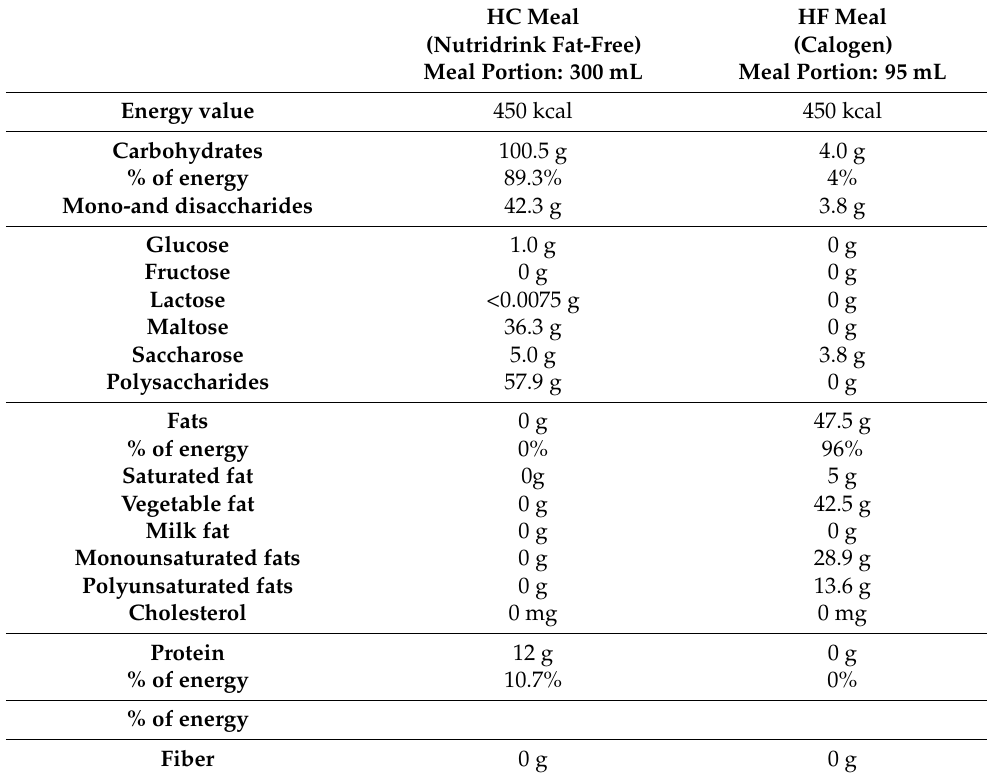
Table 2. Composition of standardized